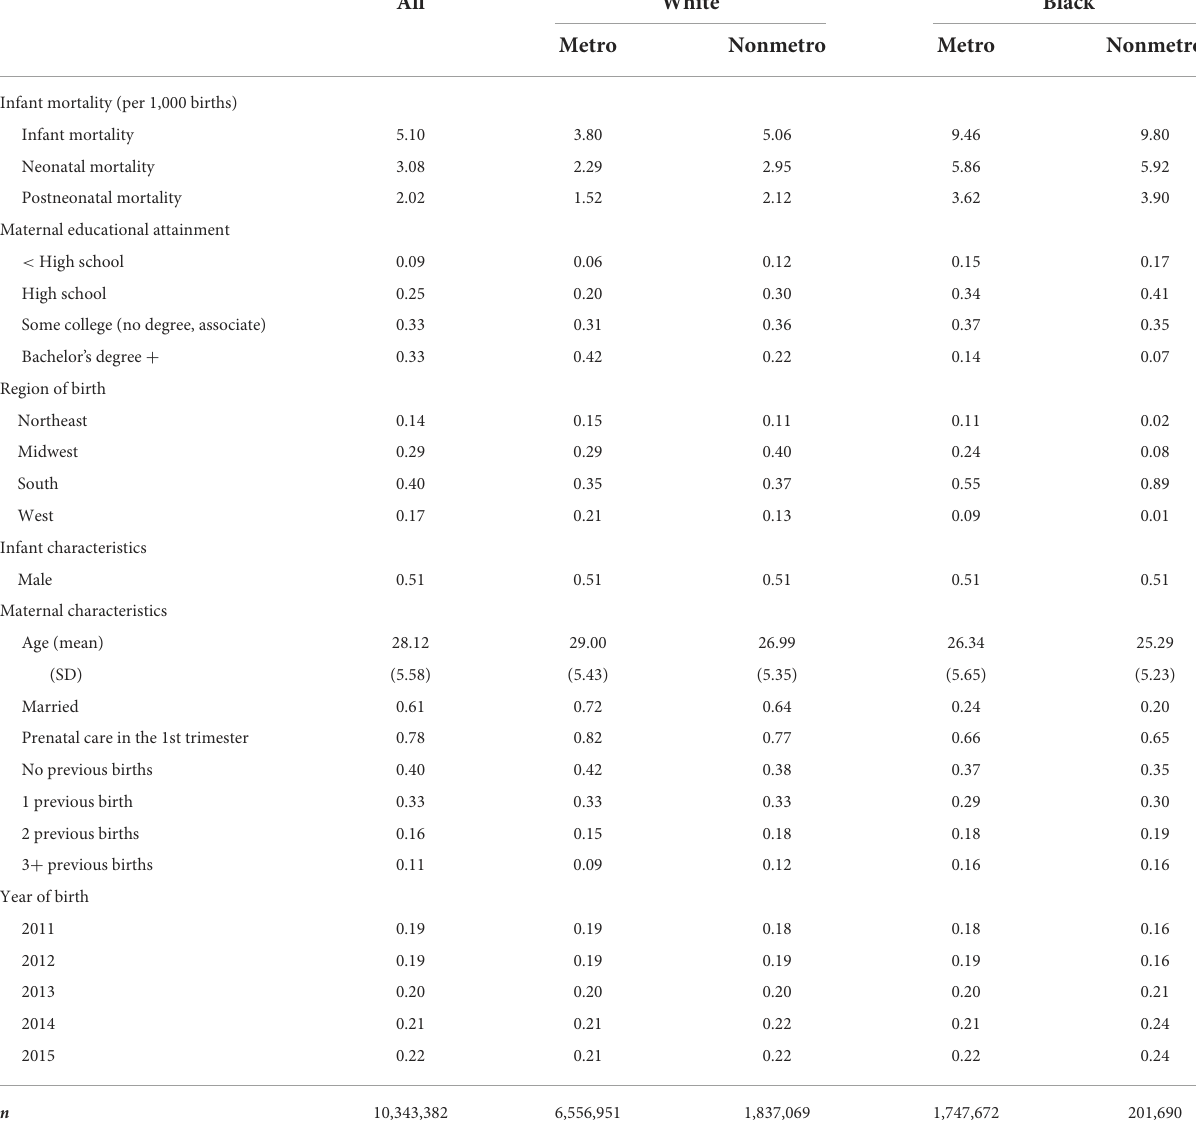
TABLE 1 Summary statistics by race and metropolitan county of residence for births between 2011 and 2015. All White Black Metro Nonmetro Metro